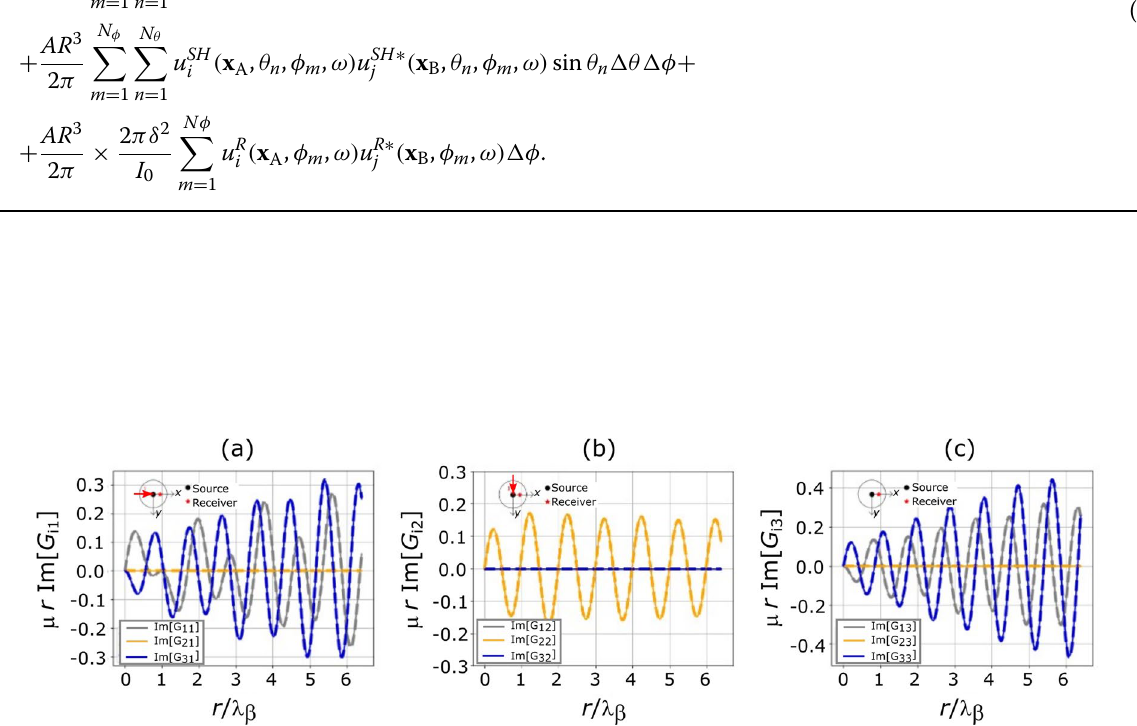
horizontal distance. Results computed using = β/ f shear wavelength. The first two plots correspond Chao’s problem = =